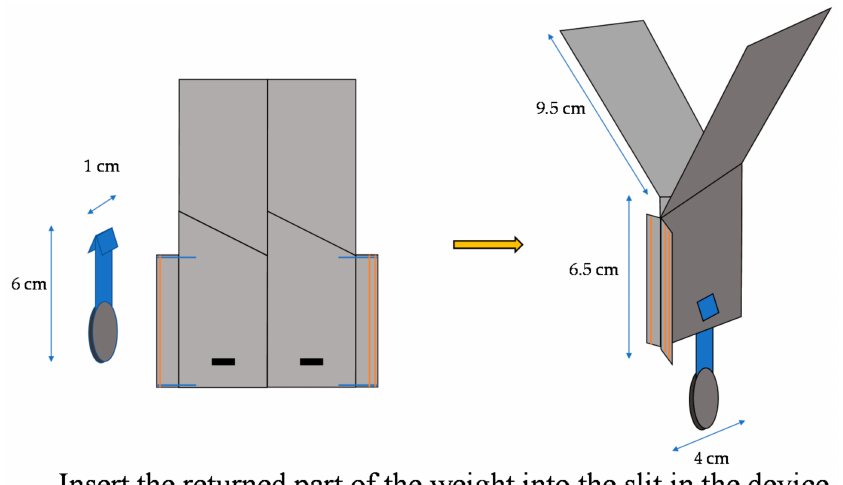
Figure 13. Falling form by weight return. Regarding the main body, its weight is 4.1 g. Fuselage length and width are 6.5 cm, and 5 cm, respectively. Wing length and width are 9.5 cm and 4 cm, respectively. Regarding a weight with a return, its weight is 2.3 g. Its length and width are 6 cm and 1 cm,